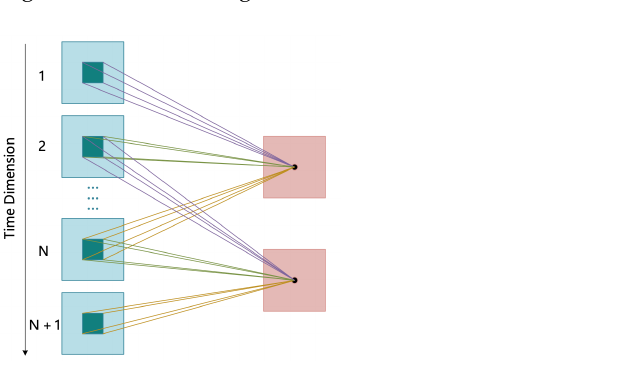
Figure 3. Three-dimensional convolution temporal feature